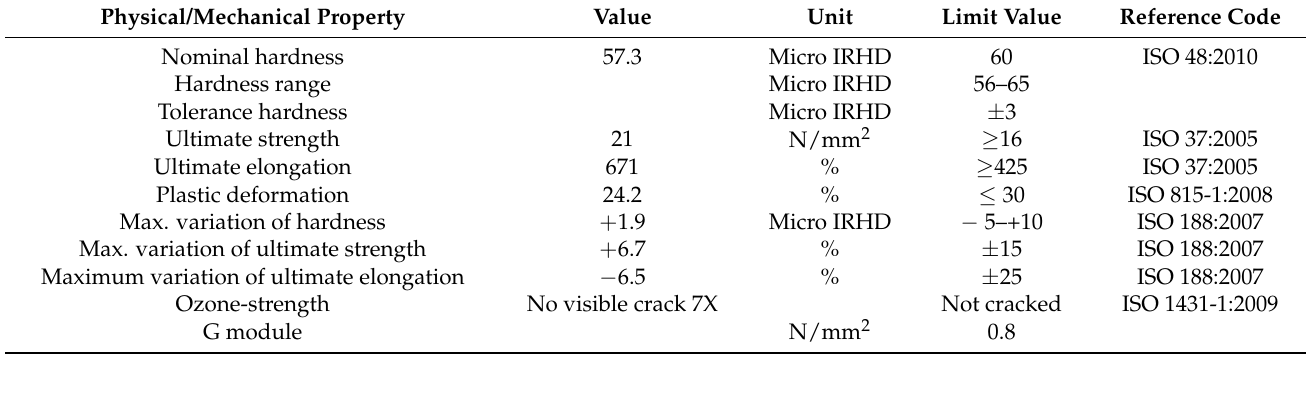
Table 2. Physical and mechanical properties of the Natural Rubber (NR).